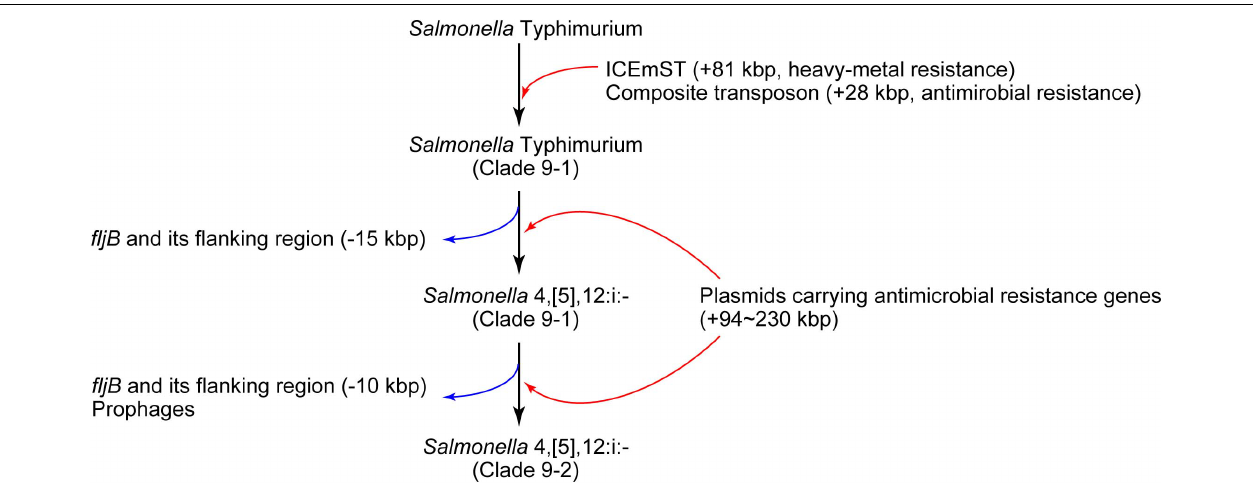
FIGURE 4 | Schematic overview of the microevolution of epidemic lineages of Salmonella Typhimurium and Salmonella 4,[5],12:i:-. The black, red, and blue arrows indicate the flow of microevolution, the acquisition of foreign genes, and genome reduction, respectively.